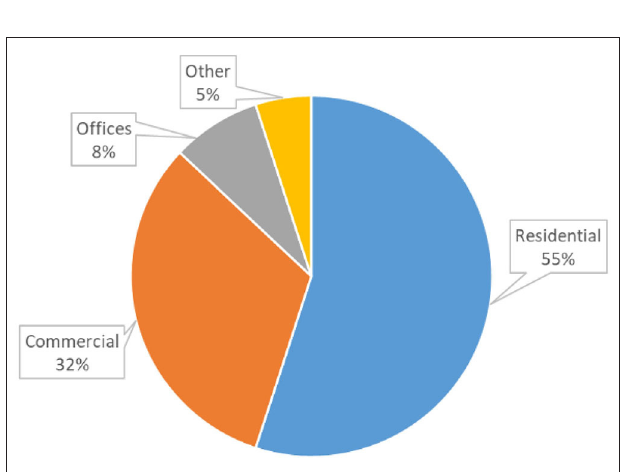
FIGURE 3 | Distribution of buildings’ final use in the territory.